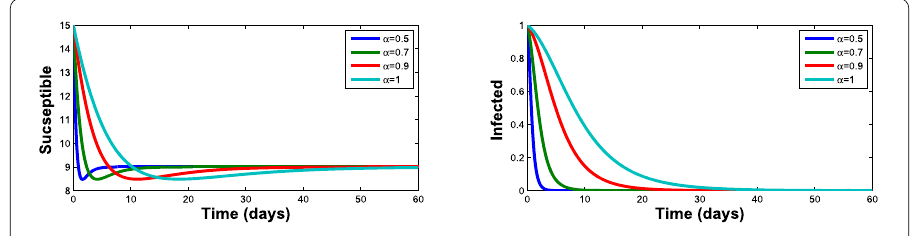
Figure 1 Stability of the disease-free equilibrium E 0